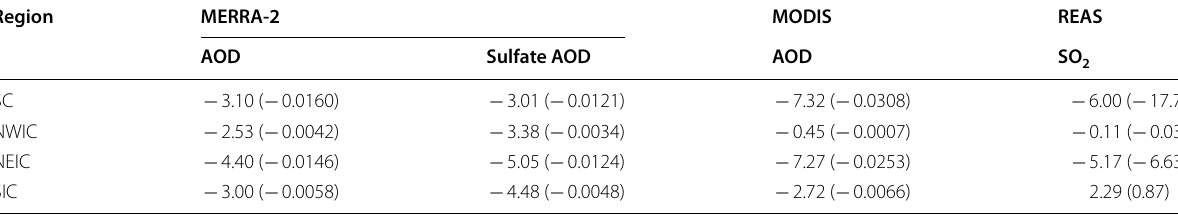
Table 3 MERRA-2 AOD, sulfate AOD, MODIS AOD, and REAS SO